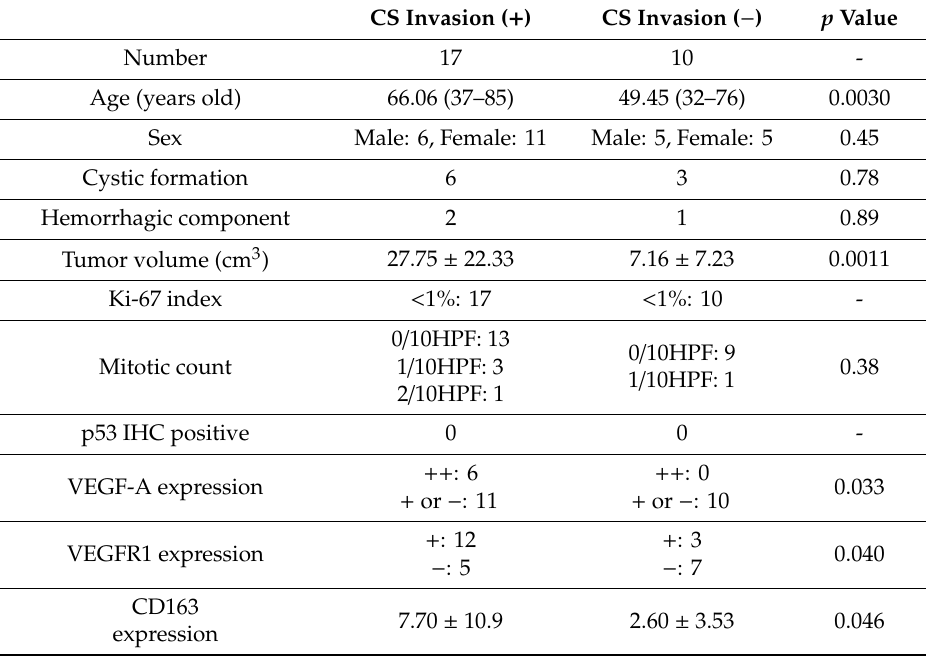
Table 1. Patient characteristics and